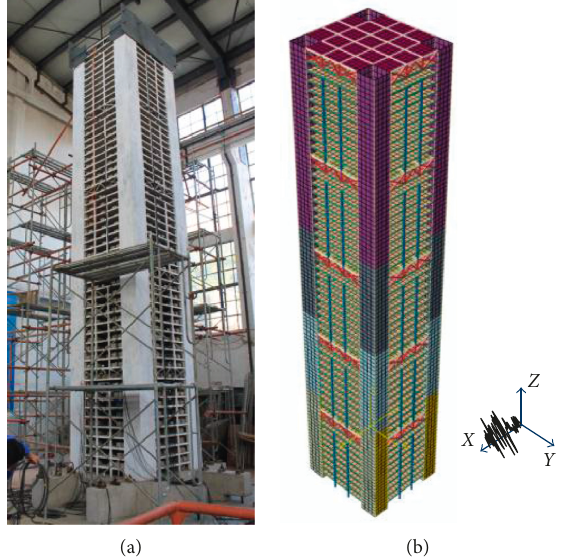
Figure 3: (a) Shaking table test model and (b) FE model of the shaking table test model.